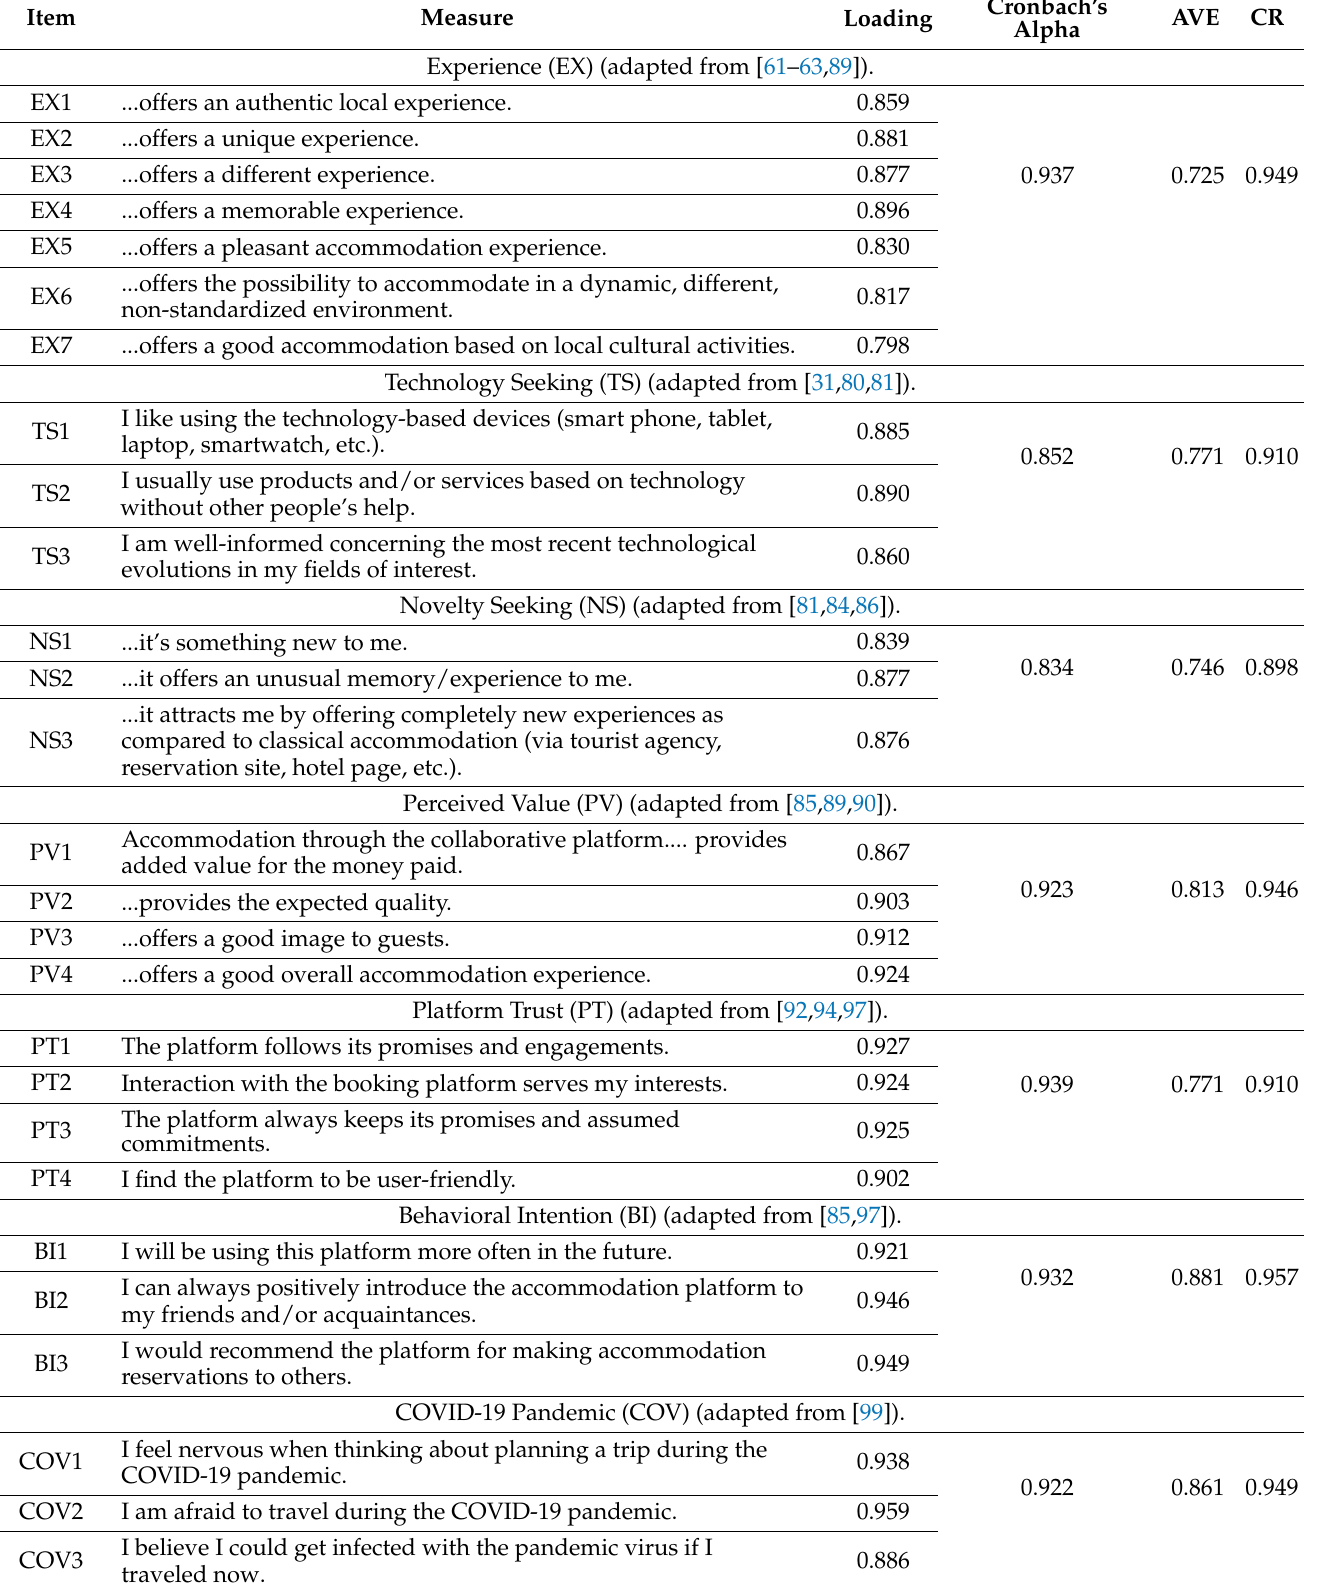
Table 1. Constructs and